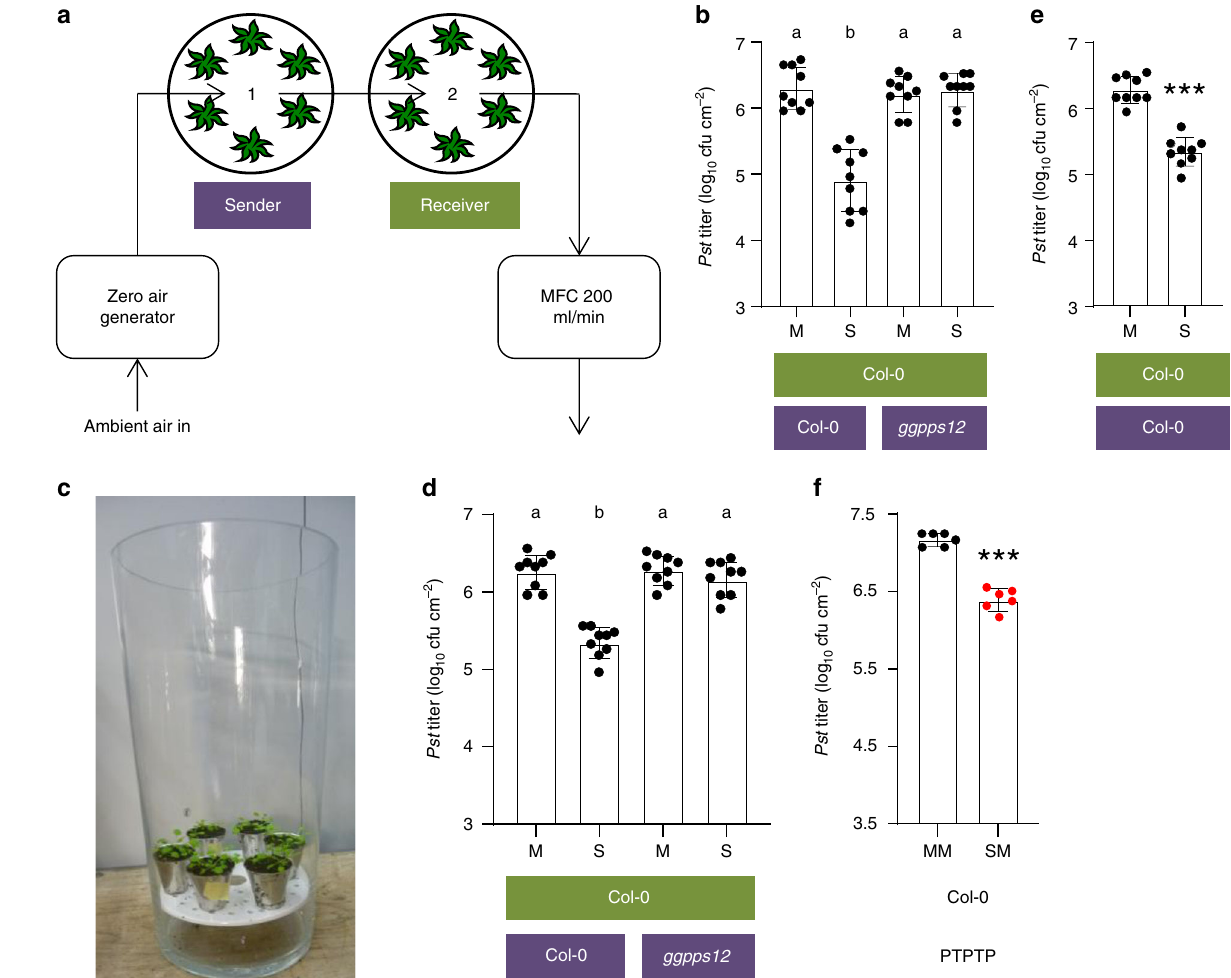
Fig. 8 PTP propagation of innate immunity in open systems. a Experimental setup of PTP experiments under dynamic/ fl ow-through conditions. Sender and receiver plants were incubated in separate, but via 1/8 ″ tubes connected vacuum desiccators. VOC-free air was derived from ambient air by a zero-air generator and pulled through the system at a fl ow rate of 200 mL min − 1 . ( b – e ) PTP experiments in the dynamic system ( b ), open glass vases ( c , d ), and open desiccators ( e ). Receivers were exposed to the emissions of Pst/AvrRpm1- infected (SAR-induced; S) or mock-treated (M) sender plants in the different experimental setups (e.g., a , c ). The plant genotypes are indicated below the panels (senders in purple and receivers in green); the treatment of the senders is indicated below the bars. After 3 days, receivers were inoculated with Pst , and the resulting in planta Pst titers at 4 dpi are shown. Dots indicate individual results from three biologically independent experiments, including three replicates each. Bars represent the average of the indicated results ± standard deviation. Different letters above bars indicate signi fi cant differences, one-way ANOVA, P < 0.05. f PTPTP experiment in Col-0 wt plants. Data summarize Pst titers in receiver 2 plants. Receiver 1 had been exposed to SAR-induced (S) or mock-treated (M) sender 1 plants in the fl ow-through system from ( a ) for 3 days. Subsequently, receiver 2 was exposed to mock-treated receiver 1 plants in the same setup. After another 3 days, receiver 2 plants were inoculated with Pst , and the resulting in planta Pst titers at 4 dpi are shown. Dots indicate individual results from two biologically independent experiments, including three replicates each. Bars represent the average of the indicated results ± standard deviation. Asterisks above bar indicate a signi fi cant difference from the mock control ( t test, P < 0.001). MFC, mass fl ow